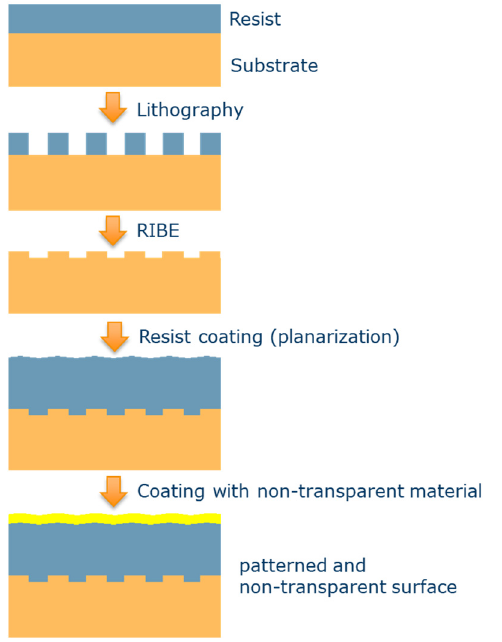
Fig. 1. Schematic process flow for the realization of the sinusoidal surface profiles